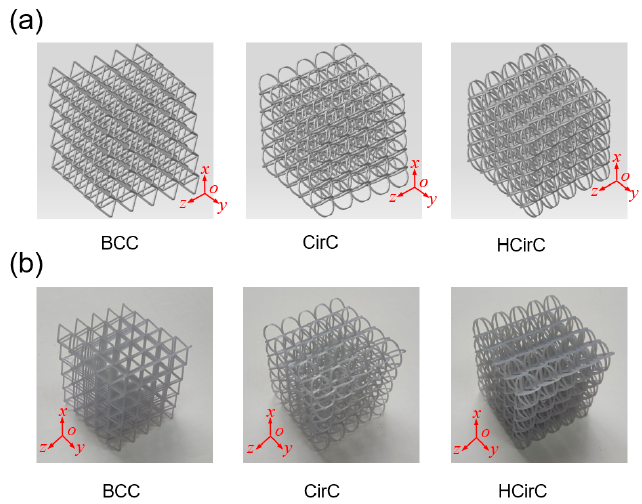
Figure 3. The designed lattice structures of BCC, CirC, and HCirC: ( a ) geometrical models; ( b ) samples fabricated by the 3D printing technique.